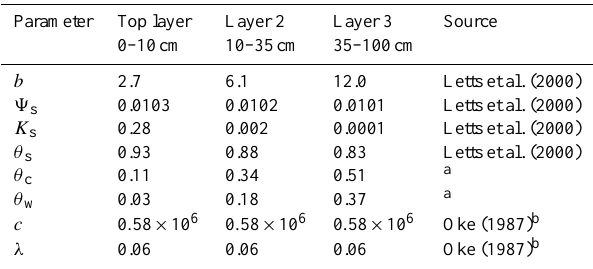
Table 2. Parameters for organic soil used in the SOC experiment. For explanation of the parameters and units, see Table